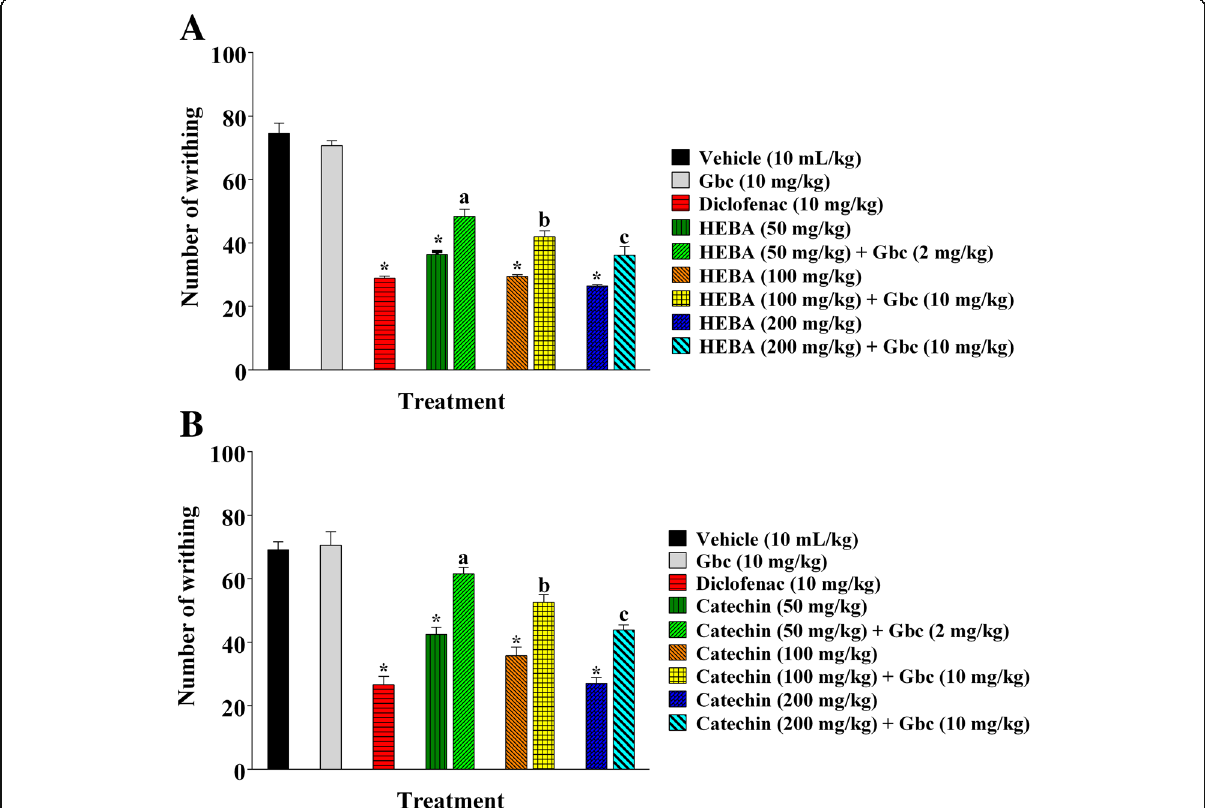
Fig. 4 Effect of diclofenac, HEBA, (+)-catechin and glibenclamide treatments in the acetic acid-induced writhing test. Panel a shows the effect of HEBA and glibenclamide pre-treatment on writhing. Panel b shows the effect of (+)-catechin and glibenclamide pre-treatment on writhing. Data are presented as mean ± SEM ( n = 5). * represents p < 0.001, compared to control group mice. a, b, and c represent p < 0.01, compared to 50, 100 and 200 mg/Kg b.w. dose treatment group respectively. HEBA = hydro-methanolic extract of the bark of A. lacucha . Gbc = glibenclamide